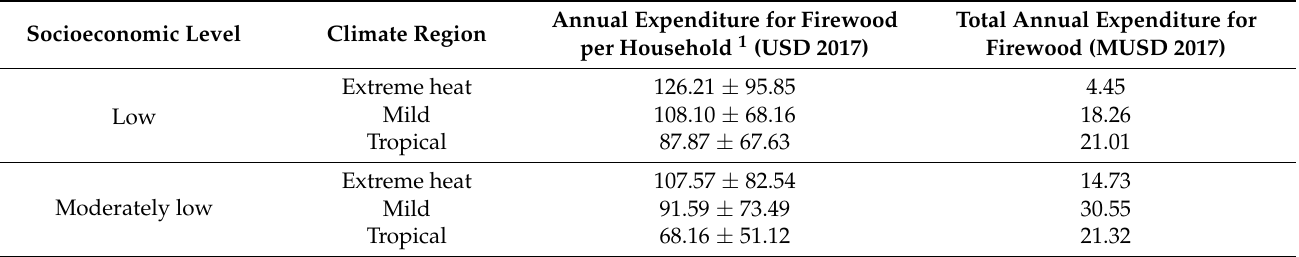
Table 6. Annual expenses per household, and total expenditure for all MSU households, for acquiring the firewood